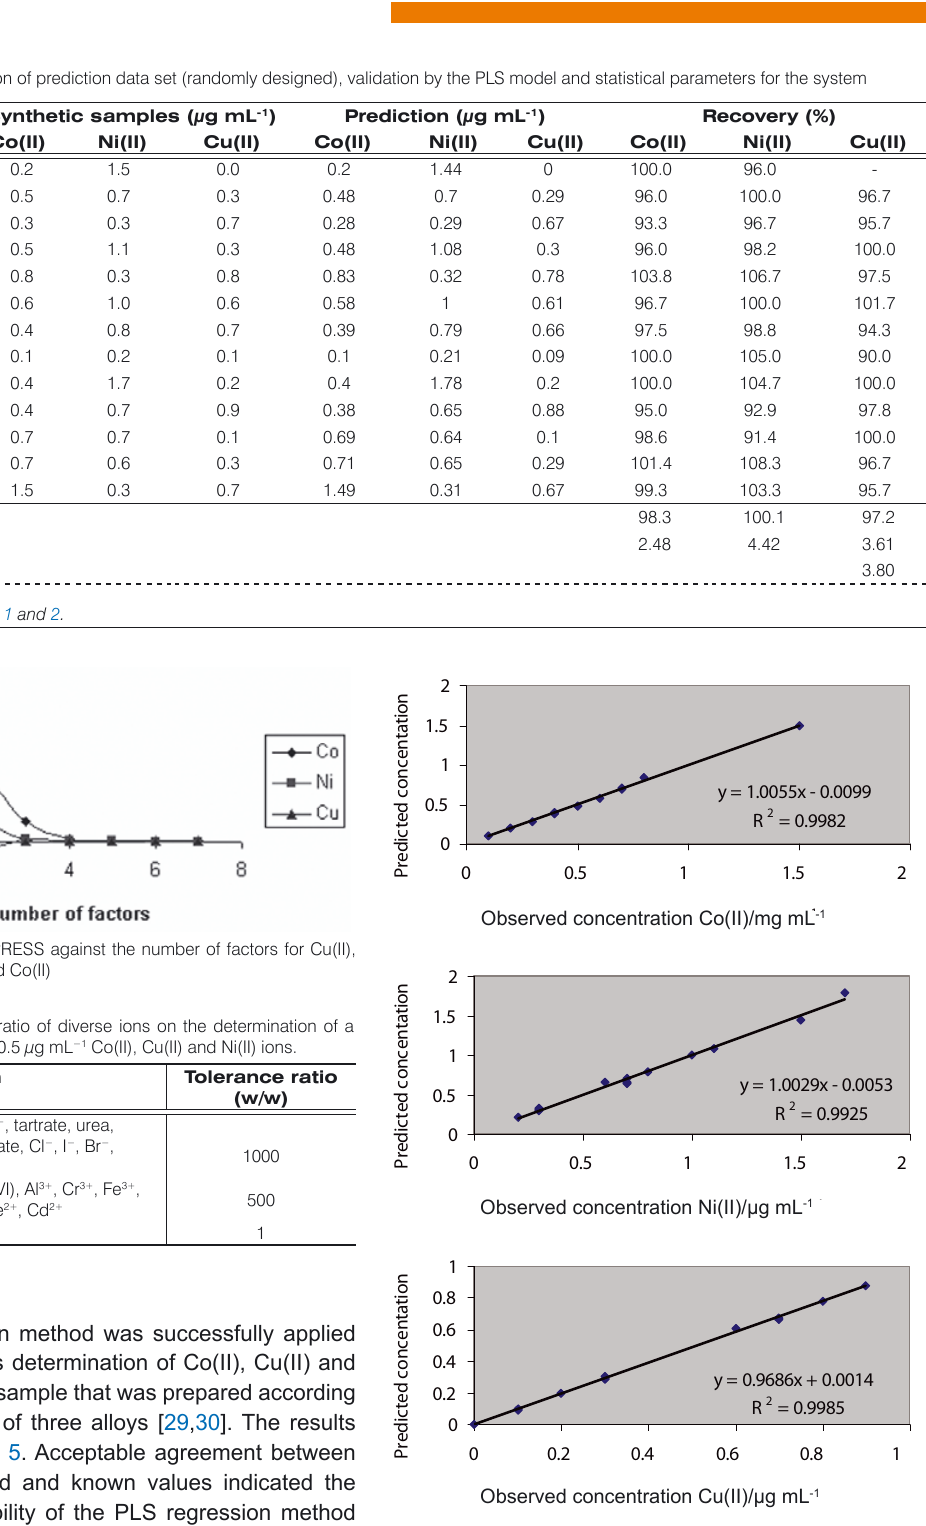
Figure 4. Predicted vs. true concentration of Co(II), Ni(II) and Cu(II) using PLS-1 by the proposed method.